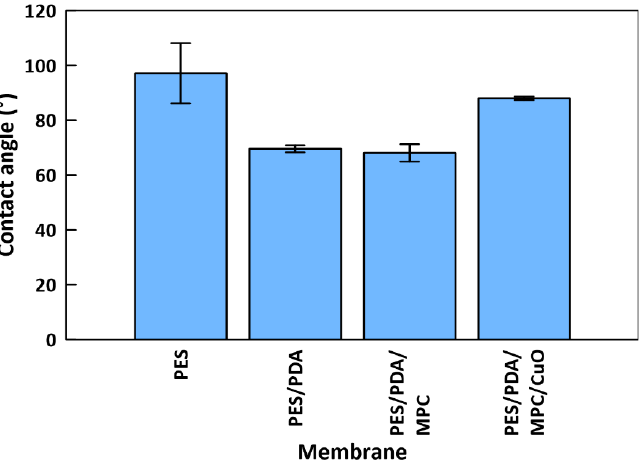
Figure 9. Water contact angles for membranes at various stages of